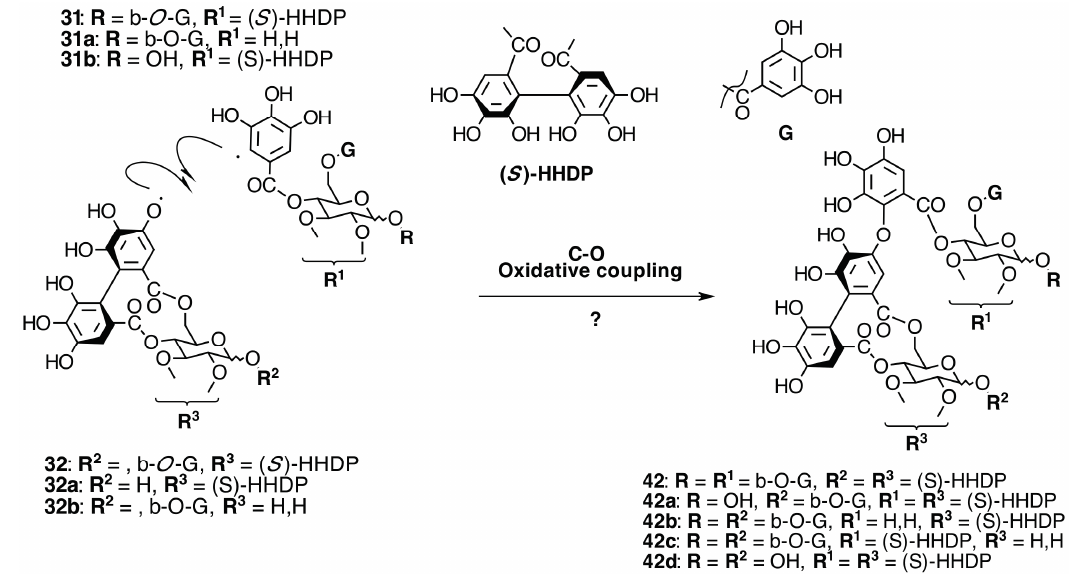
Figure 10. Route F in the biogenesis of dimeric ellagitannins in Melastomataceae. ? = Enzymes and reaction conditions are not yet